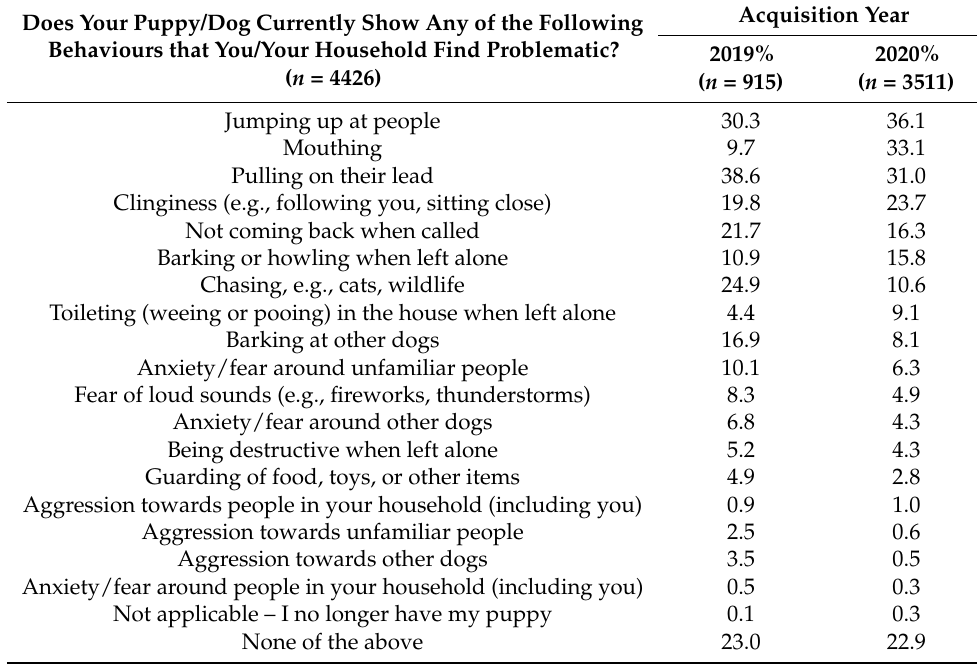
Table 12. Comparison of owner reported undesirable behaviours in 2019 puppies/dogs ( n = 915) and Pandemic Puppies ( n = 3511) at the time of the survey. The answer options listed represent all the choices available to respondents.